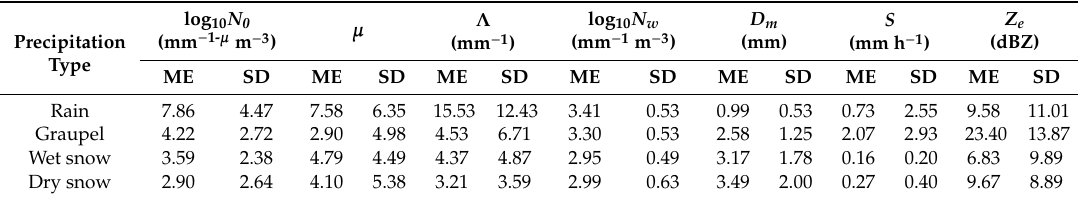
Table 4. The mean (ME) and standard deviation (SD) of log 10 N 0 , µ , Λ , log 10 N w , D m , S and Z e for di ff erent types of